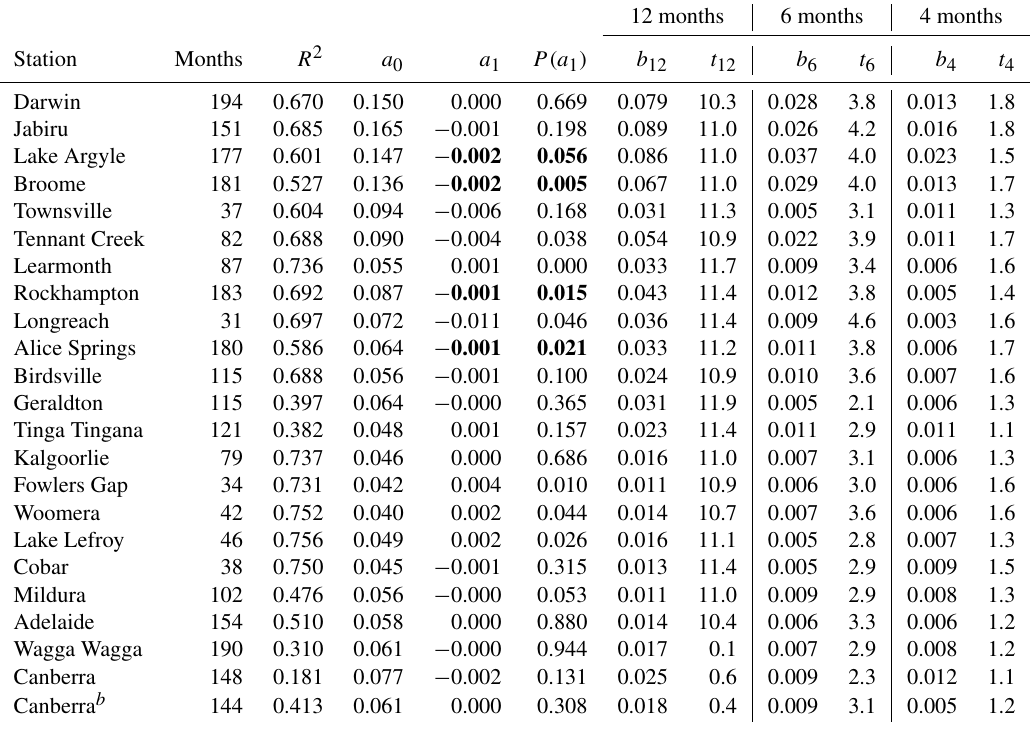
Table 2. Parameters of the fits to the aerosol optical depth time series derived from the 22 stations. R 2 is the square of Pearson’s correlation coefficient of the fit between the model given in Eq. (2) and the aerosol optical depth (AOD) time series at 500nm. The parameters a 0 and a 1 give the AOD offset and linear coefficient respectively, the latter in units of AOD per year. The following column tabulates the significance of the trend, expressed as the probability that the trend arises from a random distribution. Trends were considered significant for P(a 1 ) of < 6%, indicated in bold face. Remaining columns list the coefficients b and phase for the three sinusoidal components with periods of 12, 6 and 4 months, respectively. The phase is expressed as the time in months at which the basis cosine function reaches its first maximum. The station labelled Canberra b in the last row of the table demonstrates the improvement in the fit when the effects of the firestorm of January 2003 are excised. Exclusion of the months January, February, March and April 2003 leads to an increase in the value of R 2 from 0.181 to